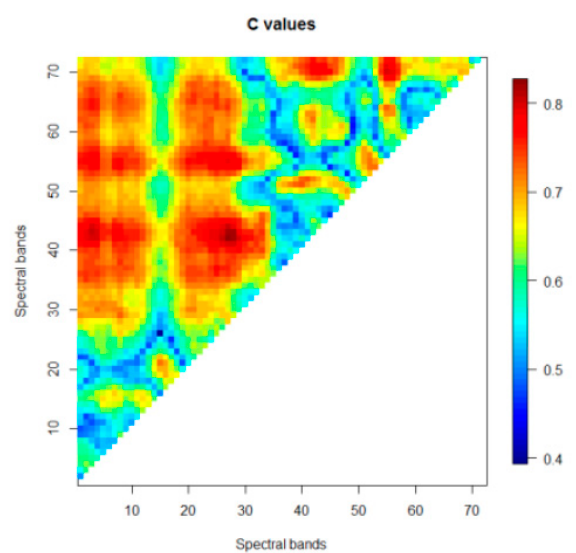
Figure 1. Results of the logistic regression on all possible two-band combinations (standardized difference vegetation index (SDVI)) for the 47 selected reference trees.